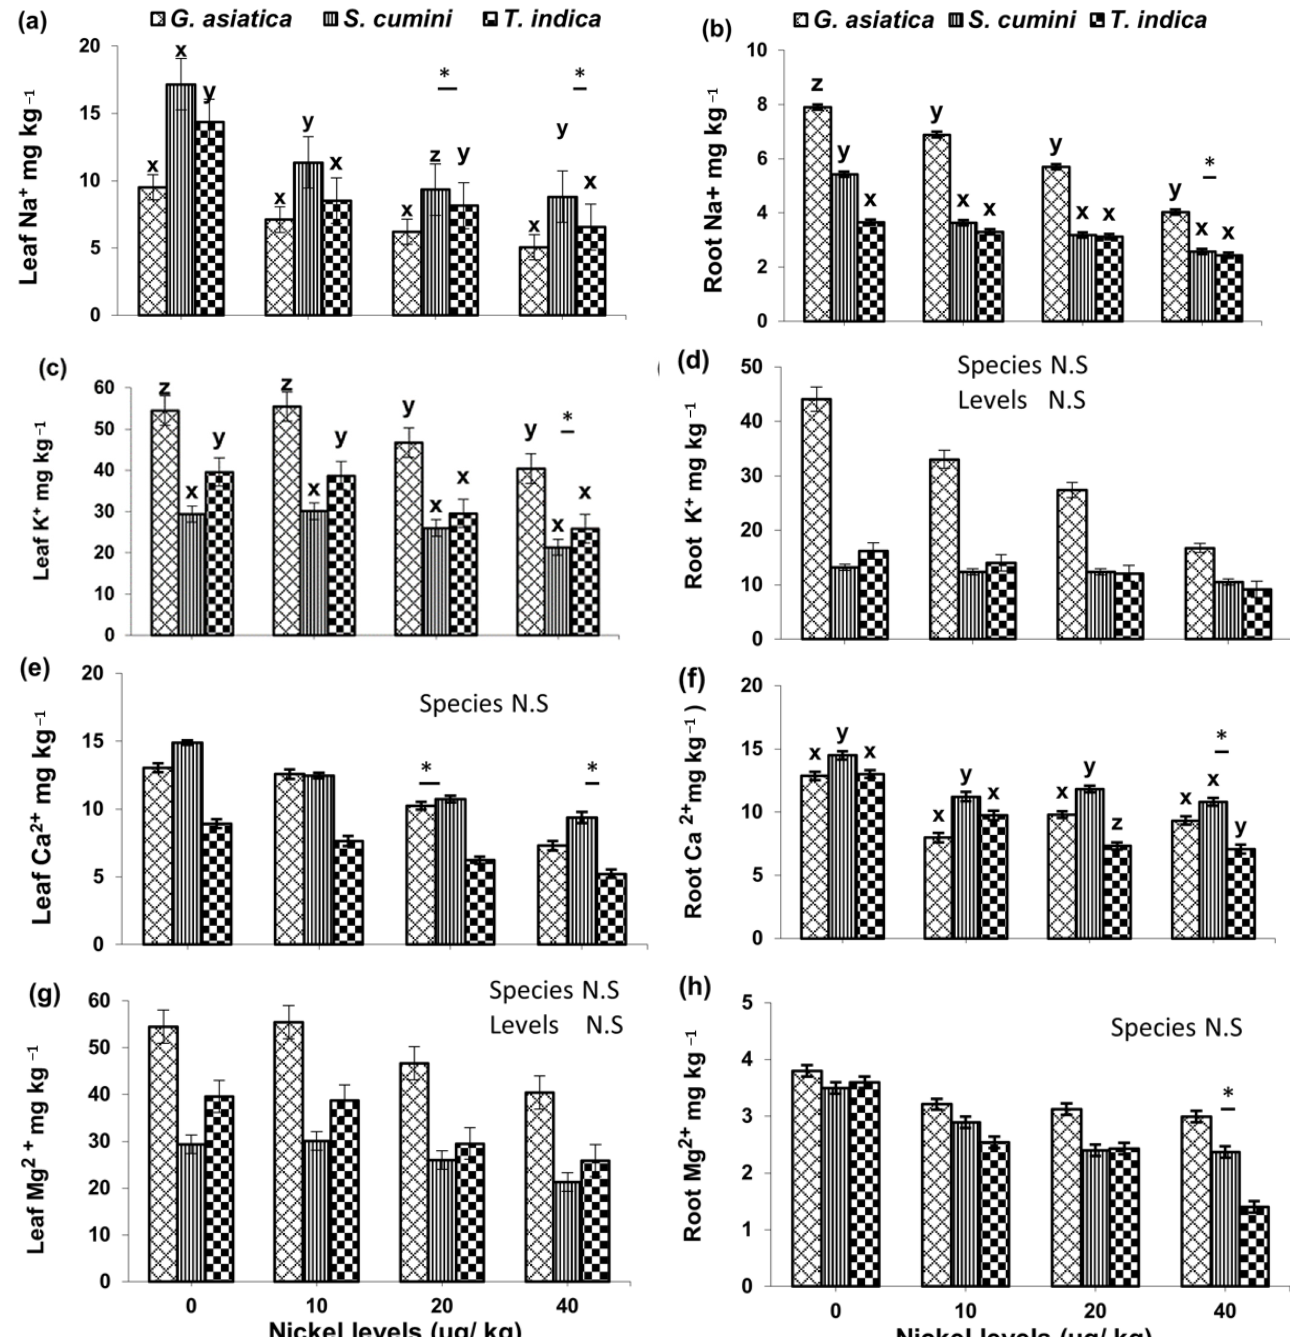
Figure 3. Macronutrient Na + , K + , Ca 2+ and Mg 2+ status in leaves ( a – d ) and roots ( e – h ) in three minor fruit species ( Grewia asiatica L., Syzgium cumini (L.) Skeels and Tamarindus indica L.) after exposure to increasing levels of Ni in the growth medium. Each mean is across three replicates with ± S.E. Different letters on each bar indicate significant difference between species (x–z), and * on each level shows a marked variability from the control, analyzed through two-factor ANOVA, with equal number of replications, followed by a post hoc multiple comparison test (DMRT).